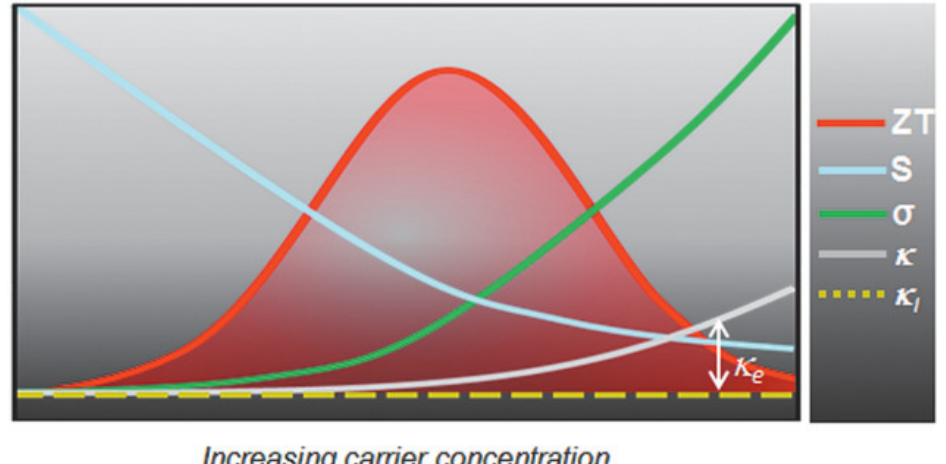
Figure 23. Schematic representation of the interrelationship and trade-off among various thermoelectric parameters. Reprinted with permission under a creative commons license [2]. Copyright 2020,